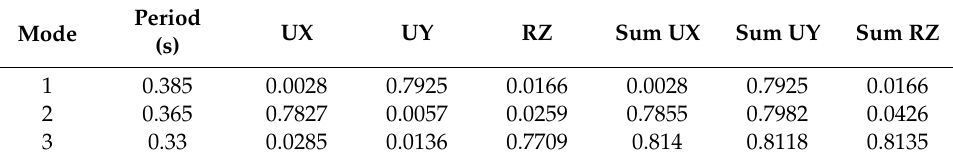
Table 11. Ratios of the modal participating mass before the reducing of the torsion.